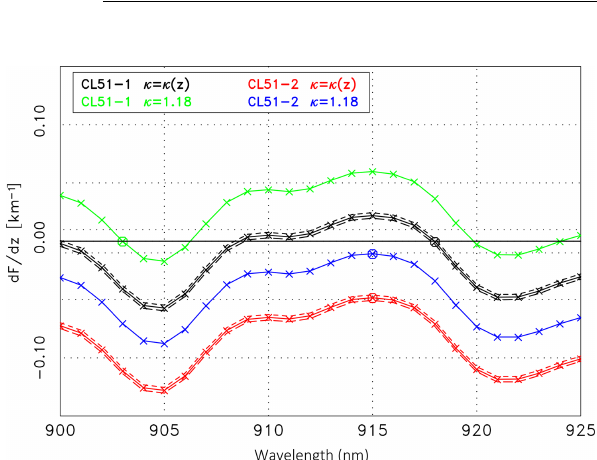
Figure 12. First derivative, d F(z,λ on )/ d z (see Eq. 15), of the ratio of the CL51 ceilometer signal and the extrapolated reference lidar signal as a function of λ on : CL51-1 (solid black line) and CL51-2 (solid red line) assuming a height-dependent κ(z) . The short-dashed and long-dashed lines are for the minimum and maximum S p val- ues, respectively. The integer wavelength corresponding to the min- imum of the absolute values of d F/ d z is indicated by a circle. The green (CL51-1) and blue (CL51-2) lines correspond to d F/ d z as- suming a constant κ derived from AERONET. All curves concern Case